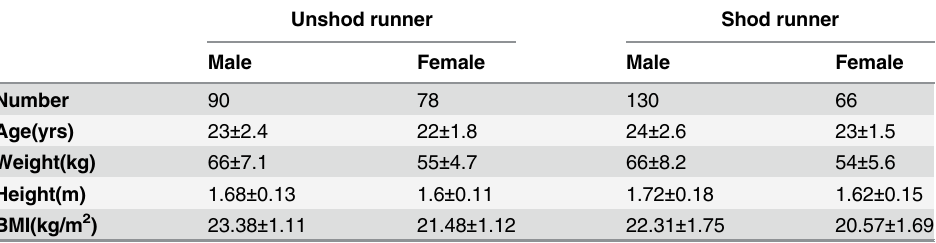
Table 1. The basic demographics of habitually unshod and shod